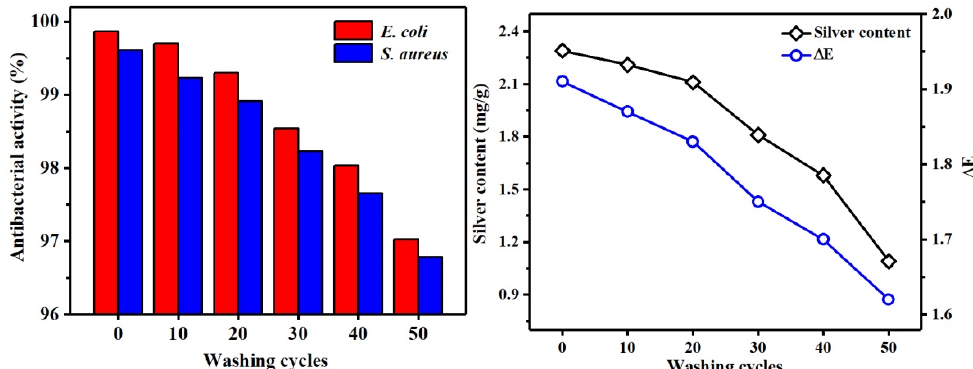
Figure 13. Distribution of antibacterial rate and antibacterial washing resistance of Ag/Cotton ( left ), distribution of silver content and ∆ E ( right ).